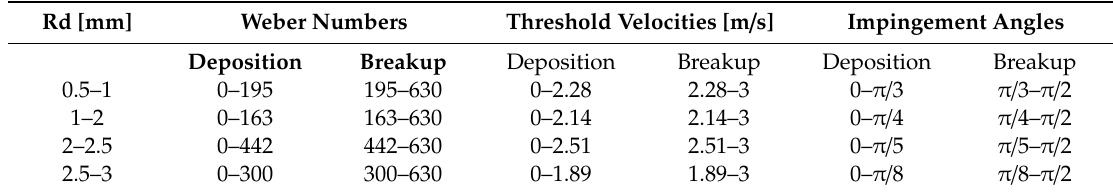
Table 4. Threshold velocities, impingement angles, and Weber numbers su ffi cient for drop breakup when impinging on the